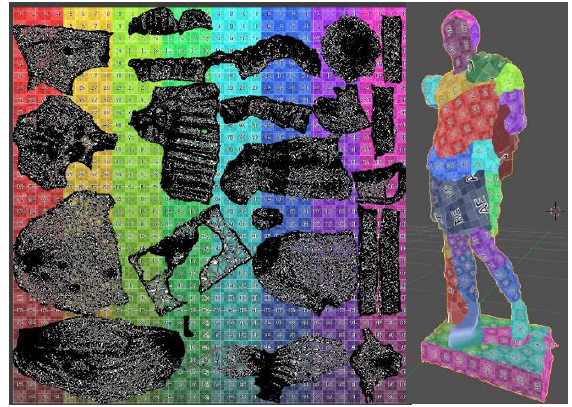
Figure 8. Blender UV-texture mapping process: on the right the 3D model and the identified seams used for subdividing the mesh; on the left the unwrapped UV-maps of each